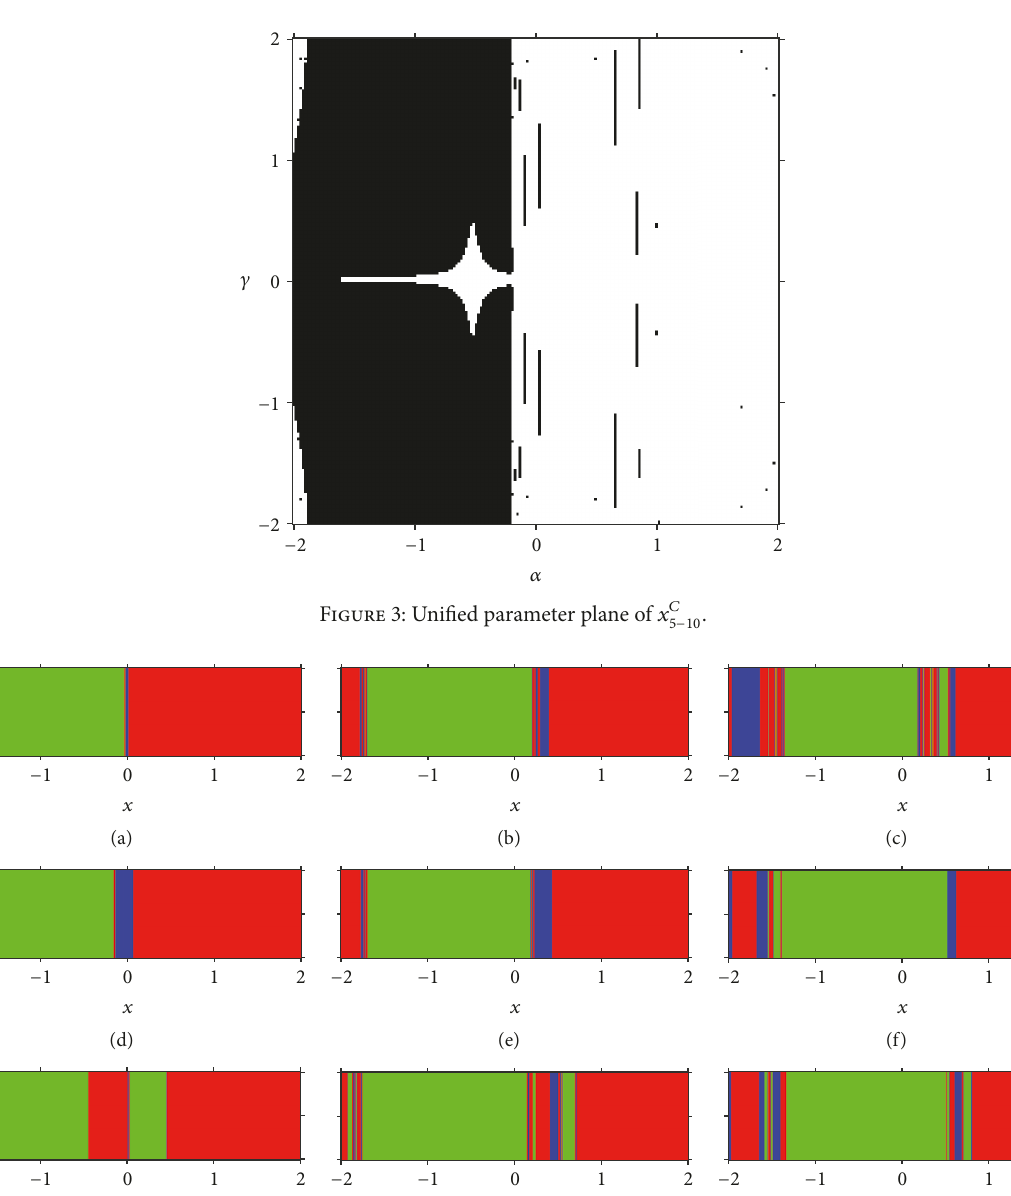
𝑥 ∗ 𝑥 ∗ 1 , green: 2 , and blue: ∞